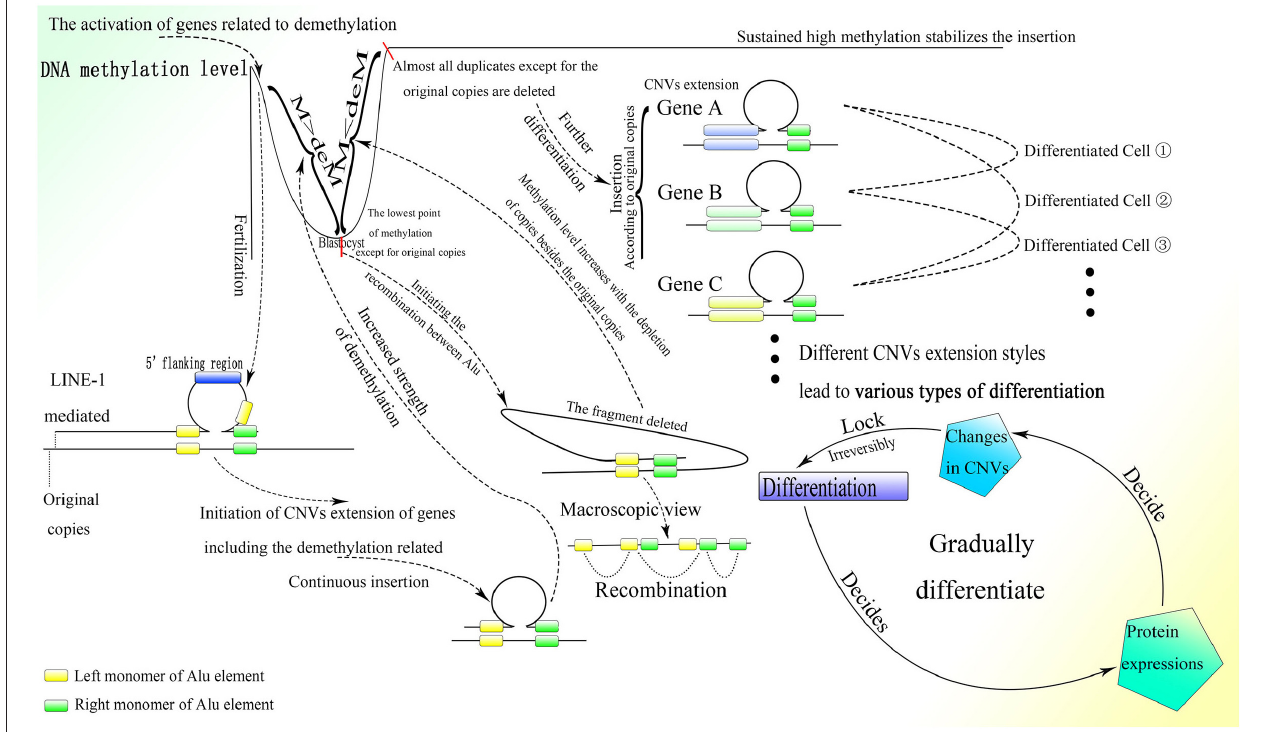
FIGURE 7 | The process of embryonic development with the CNV extension mechanism. After fertilization, the CNV extension of genes related to demethylation could be initiated by LINE-1 inserting the 5 ′ flanking regions of these genes through 3 ′ transduction. Then continuous extension would be mediated by the Alu element. When the demethylation effect is sufficient to suppress the methylation effect, the Alu element would be thoroughly demethylated and HR could occur among them, leading to the deletion of inserted DNA on the genome, thus initializing cells in ICM. Then the CNVs of different genes would be extended according to the original copies of the corresponding genes. The different styles of CNVs extension in different genes would be developed next, resulting in various types of differentiation. Specifically, protein expression could influence changes in CNVs, which would irreversibly decide the differentiation, and then the differentiation could affect protein expression and lead to further differentiation. This gradual differentiation would ultimately construct an entire